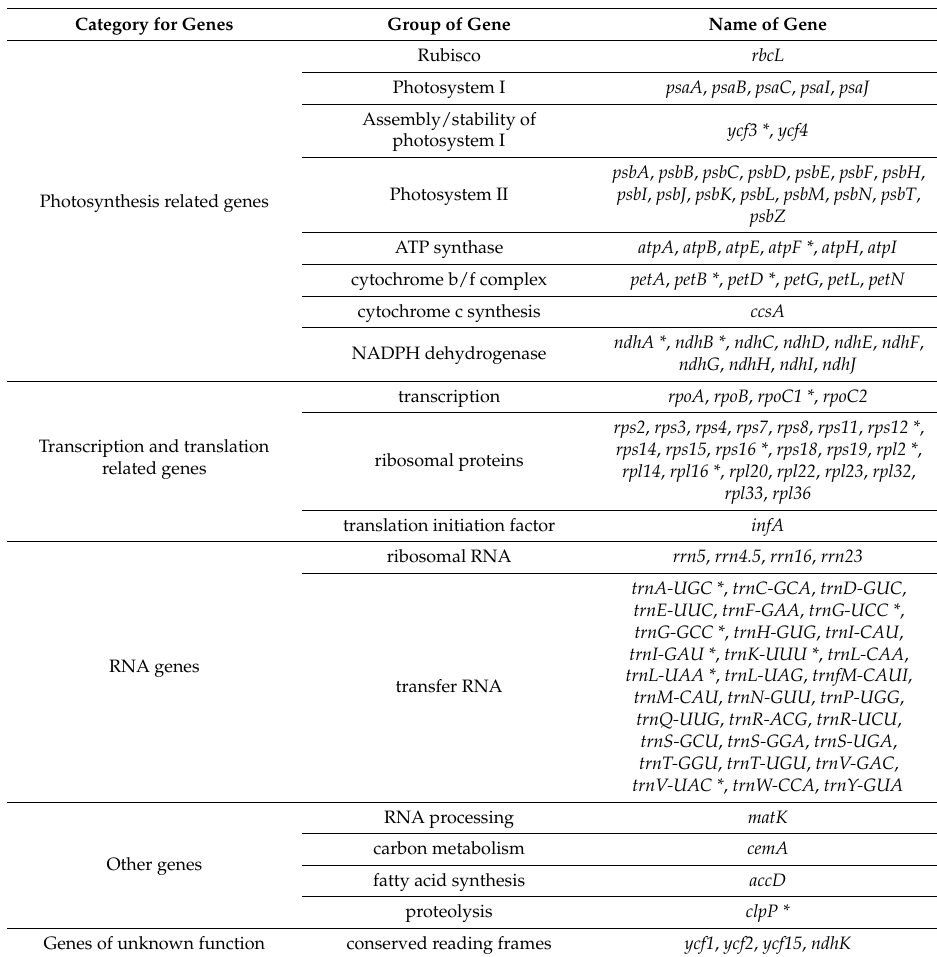
Table 1. A list of genes found in the plastid genome of Forsythia suspensa.